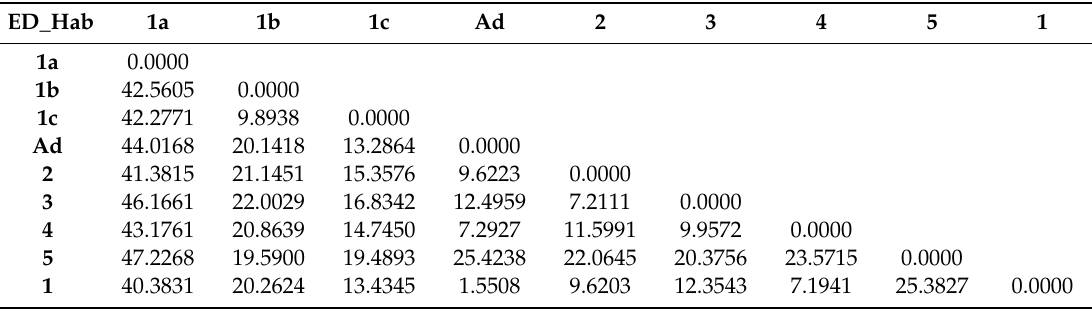
Table 6. Euclidean distances using the Coulomb operator, according to Equation (8).